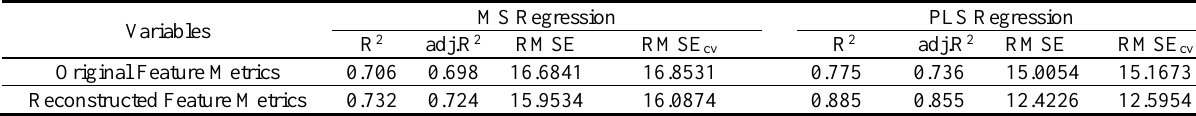
Table 2. Summary of estimation accuracies of AGB using original LiDAR feature metrics and reconstructed LiDAR feature metrics respectively. Two types of regression models represent the better ability of estimating AGB using reconstructed feature